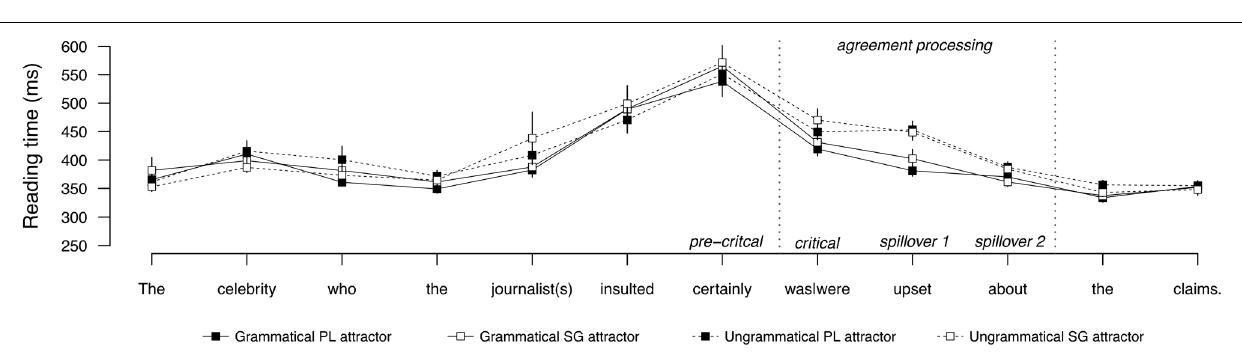
FIGURE 4 | Word-by-word reading times for the subject attractor conditions in Experiment 2. Error bars indicate standard error of the